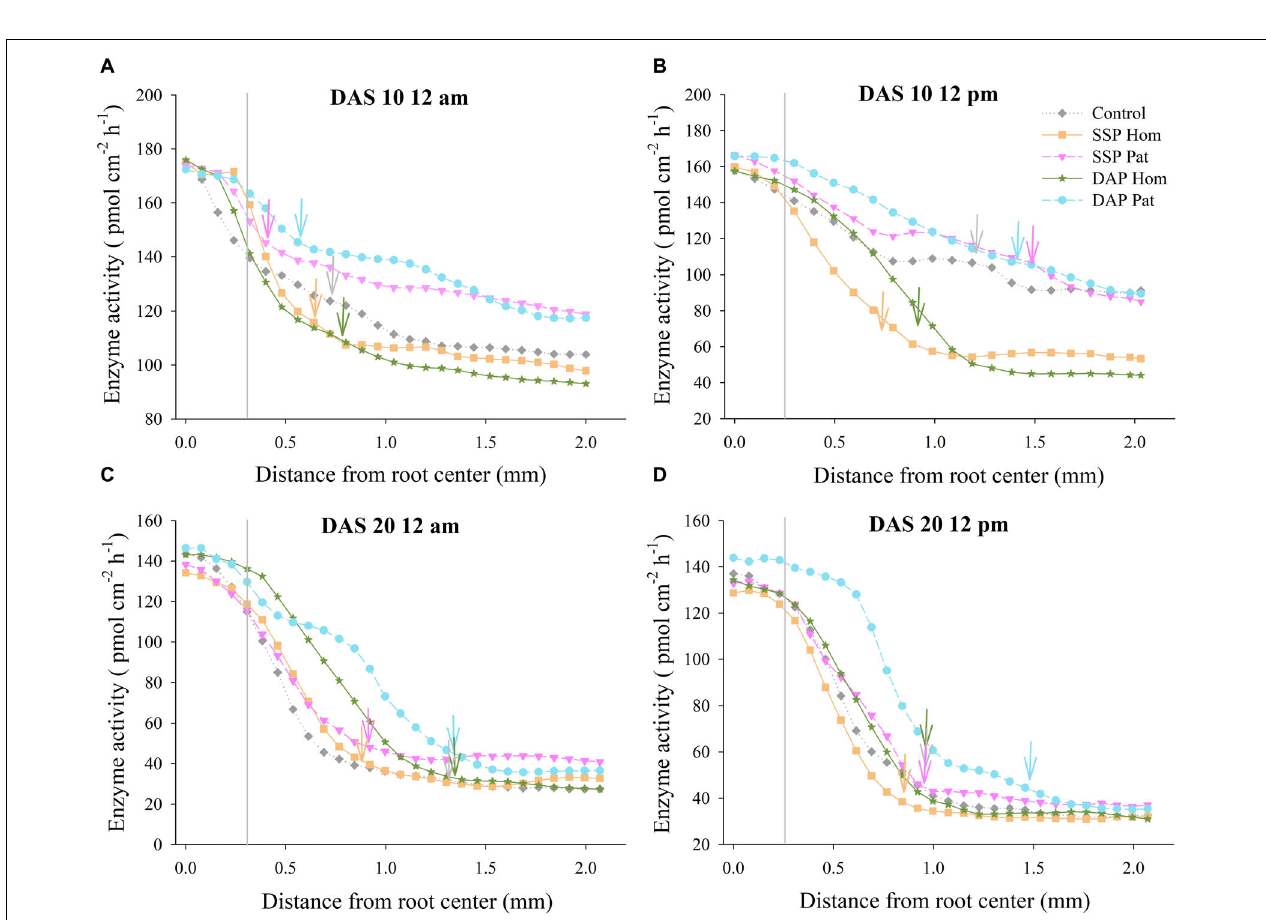
FIGURE 9 | Acid phosphatase activity as a function of distance from root axis to the surrounding soil in P-rich patches. (A–D) represents different sampling time in fluvo-aquic soil, respectively. Vertical gray lines refers to average root radius, and vertical arrows represent rhizophere extension for enzyme activity. Each line calculated from four replicates, error bars are omitted to improve